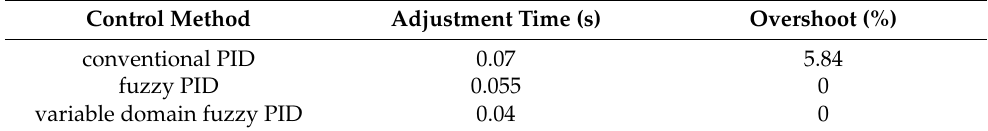
Table 5. Comparison of simulation